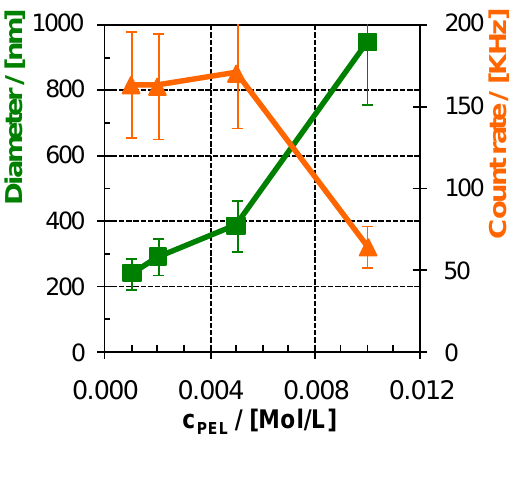
and count rate (CR) of PEC-0.6 dispersions of H ). PEL